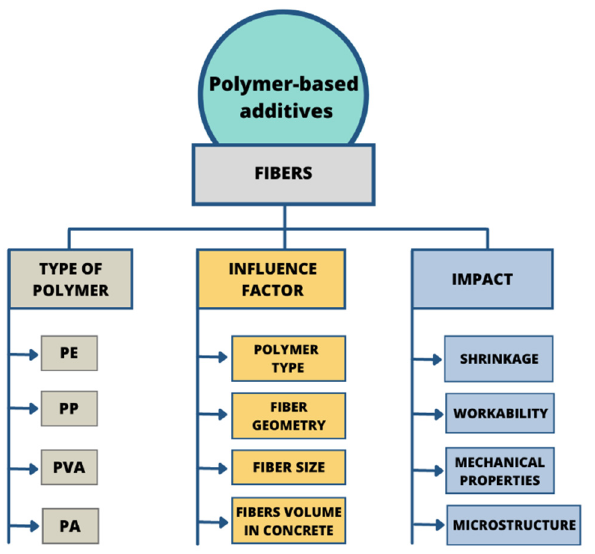
Figure 7. Influence of polymeric fibres on the properties of concrete-based composites. Immunity to corrosion and alkaline reactions, salts, chlorine and microorganisms count among the most beneficial results achieved by applying polymer-type fibres.